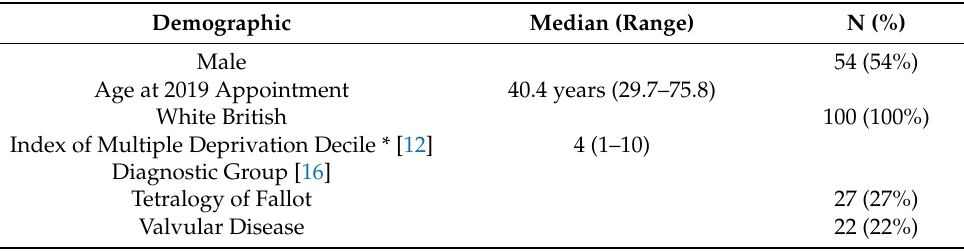
Figure 1. ( a ) ACHD AP class of the study cohort and ( b ) number of clinic appointments attended during the study period by the study cohort. Table 1. Study Population (n = 100) (AVSD: atrioventricular septal defect, ASD: atrial septal defect, VSD: ventricular septal defect and TGA: transposition of the great